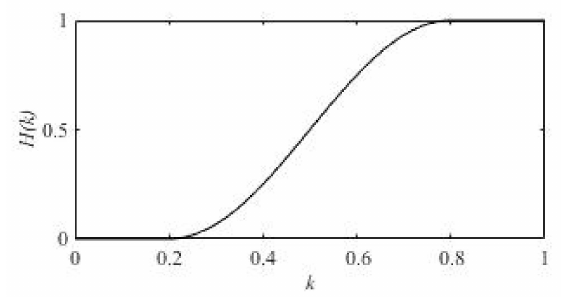
Figure 1. The frequency-domain response function of a high-pass